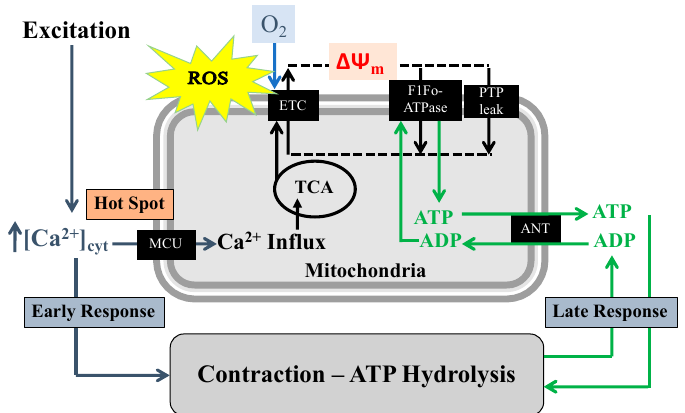
Figure 2. Our conceptual model demonstrates that in ASM cells, excitation, contraction, and energy production are coupled with two mechanisms. (1) On a shorter timescale, agonist-induced elevation of [Ca 2+ ] cyt triggers activation of the mitochondrial Ca 2+ uniporter (MCU) and Ca 2+ influx, which increases tricarboxylic acid cycle (TCA) activity thereby providing H + to the electron transport chain (ETC). (2) On a longer timescale, agonist-induced force/contraction results in ATP consumption and an increase in ADP, which increases ADP influx into mitochondria via the adenosine nucleotide transporter (ANT), stimulating ATP synthase (F1Fo-ATPase) activity. With excessive mitochondrial Ca 2+ influx, an overload in mitochondrial Ca 2+ concentration ([Ca 2+ ] mit ) can trigger the opening of mitochondrial permeability transition pores (mPTP), which are large conductance channels present in the inner mitochondrial membrane that reduce the H + gradient and mitochondrial membrane potential ( Δψ m ).